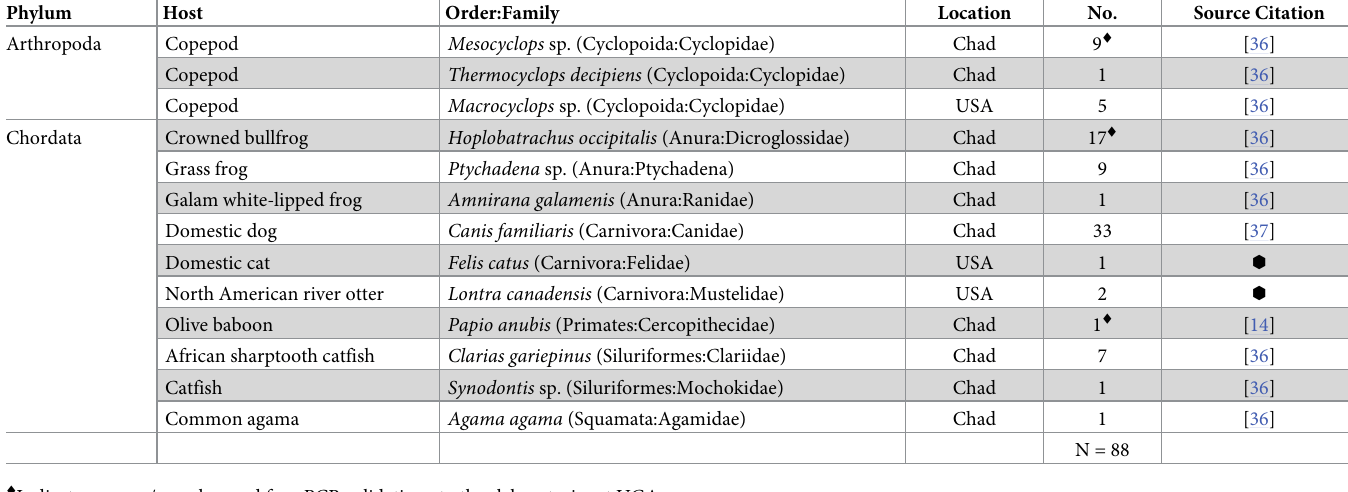
Table 3. Summary of non-target host samples used to estimate diagnostic sensitivity and specificity showing host phylum, common name, scientific name, location of origin, and number of